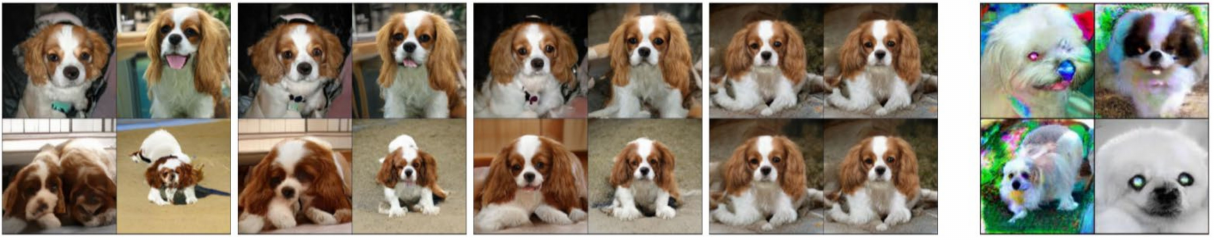
Figure 15. Truncation technique of BigGAN